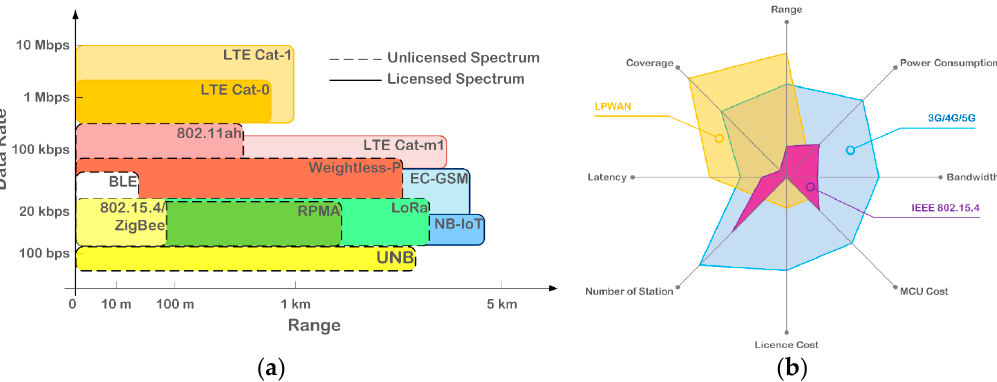
Figure 1. Communication technologies utilized in IoT applications: ( a ) Data rate versus range comparison of wireless technologies, ( b ) comparison of a low power wide area network (LPWAN) with IEEE 802.15.4 and 3G/4G/5G cellular communication technologies.